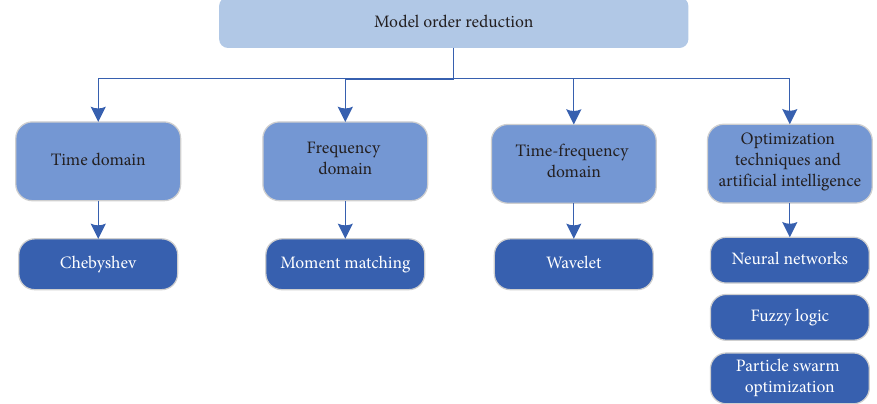
Figure 1: Flow chart of model order